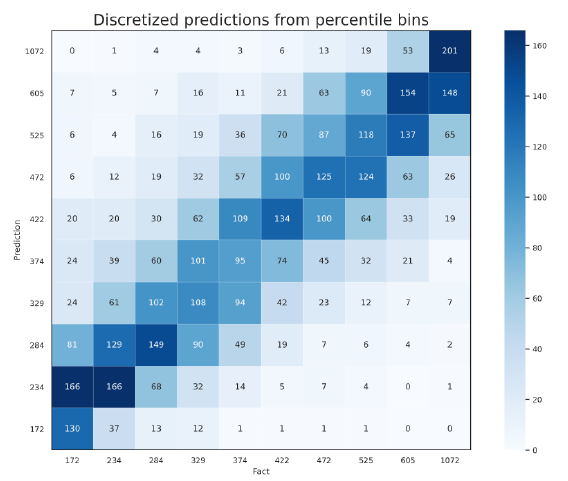
Figure 17. Discretised prediction output from the hybrid CNN in percentile bins. Predictions are binned into ten percentile bins (10, 20, ..., 100) derived from the actual distribution. The axes’ labels mark the upper bound of each percentile